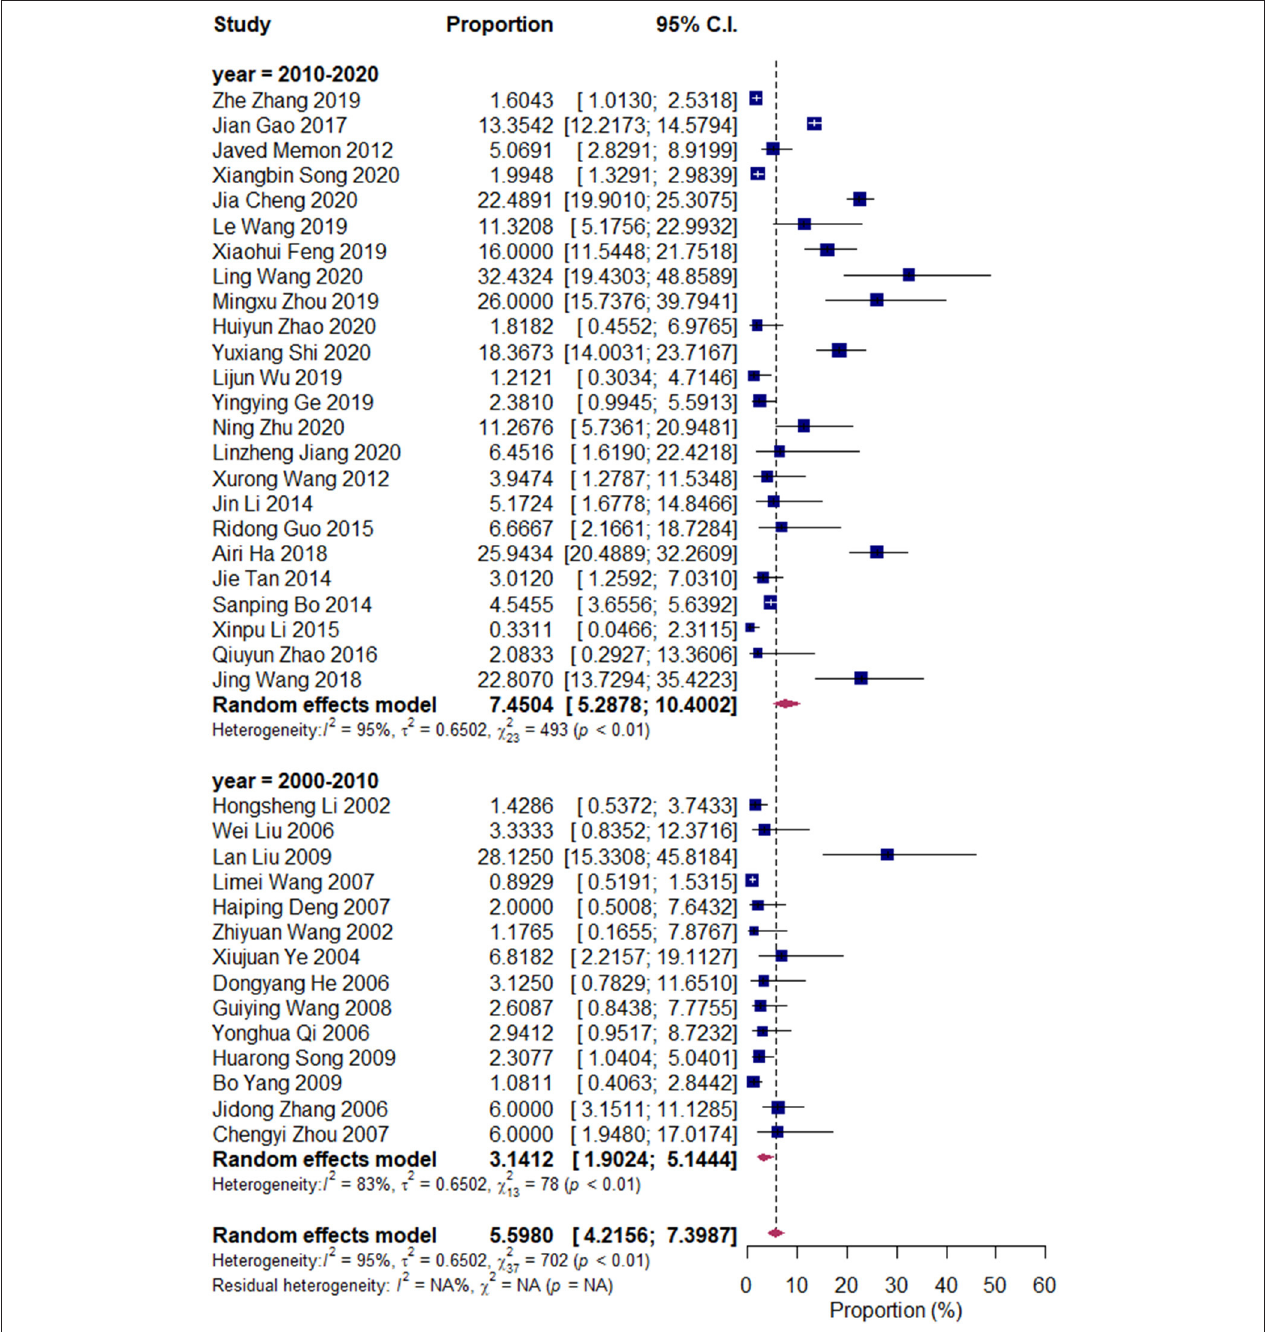
Klebsiella spp. can induce bovine mastitis; antimicrobial treatment is normally used for mastitis prevention and control